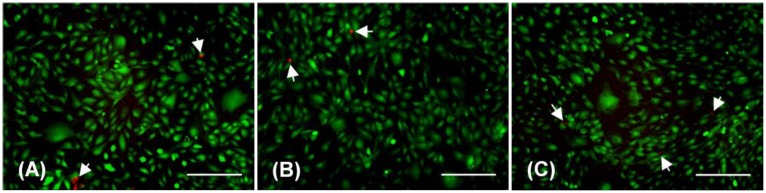
Fluorescent LIVE/DEAD images of BAECs after exposure to elevated hydrostatic pressure for 3 hours.Cells were depressurized by either rapid depressurization (A) or slow depressurization (B), or exposed only to ambient atmospheric pressure (negative control) (C), and then stained with LIVE/DEAD assay. Live cells are green; dead cells are stained red and indicated by the white arrows. Images represent data gathered from three replicates per experimental group. Each well was surveyed in its entirety and at least two representative images were taken for each experimental group. Scale Bar = 100 μm.